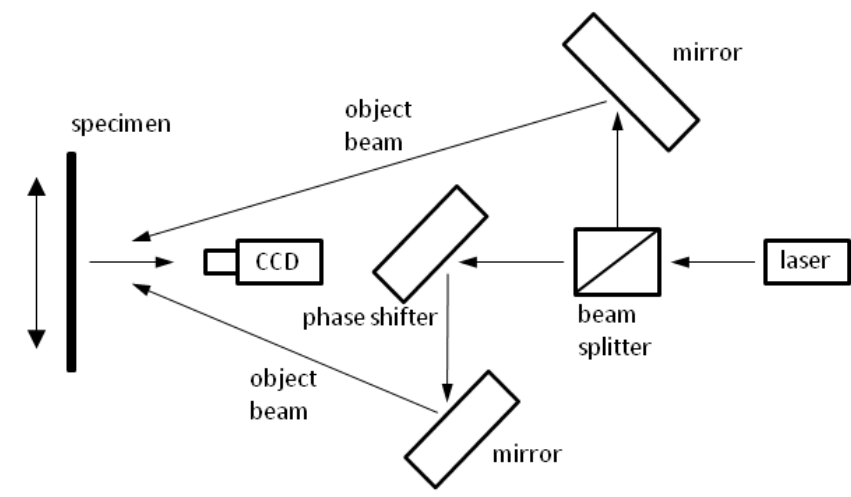
Figure 1. Schematic drawing of the Michelson interferometer and electronic laser speckle interferometry (ESPI) optics set-up for in-plane